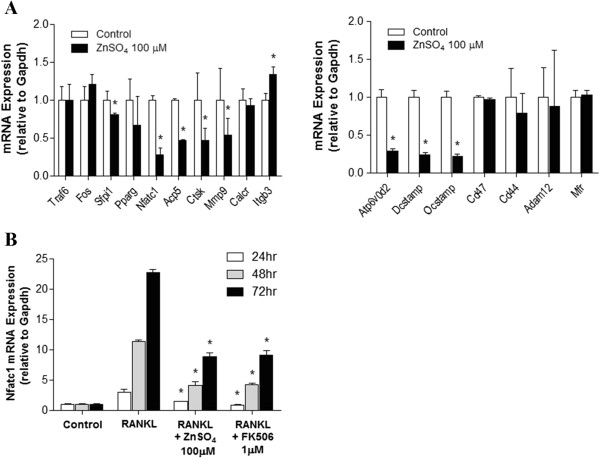
Zinc regulates the mRNA levels of Nfatc1 and its target genes during BMM osteoclastogenesis. (A) BMMs were cultured in the present of M-CSF (30 ng/ml) and RANKL (120 ng/ml) for 4 days with or without ZnSO4 (100 μM). In RANKL-induced osteoclasts, mRNA expression of osteoclast marker genes (left panel) and fusion-related genes (right panel) were determined using real-time PCR. The results are expressed relative to each mRNA on day 4. (B) BMMs were cultured with M-CSF (30 ng/ml) and RANKL (120 ng/ml) in the presence or absence of ZnSO4 (100 μM) and FK506 (1 μM). After 24, 48, or 72 hours, total RNA was extracted from the cultured BMMs and mRNA levels were examined using real-time PCR. Data are presented as the mean ± S.D. of three independent experiments; * p < 0.05 compared to control and RANKL, respectively.